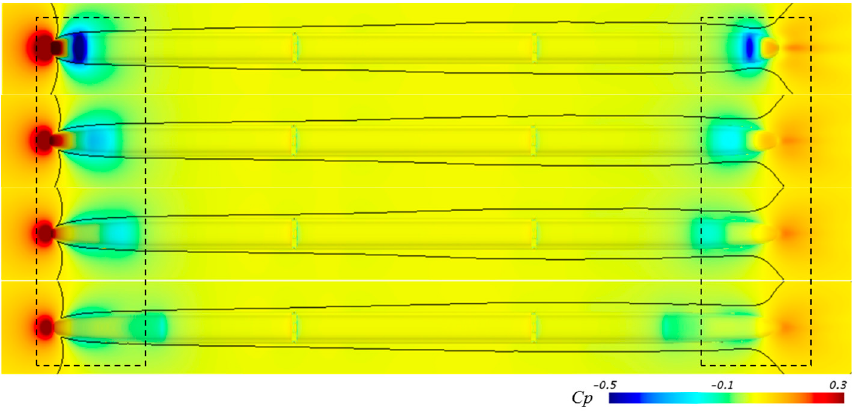
Figure 18. Time-averaged pressure at a height of 1.6 m from TOR (from top to bottom: 4, 7, 9, and 12 m).